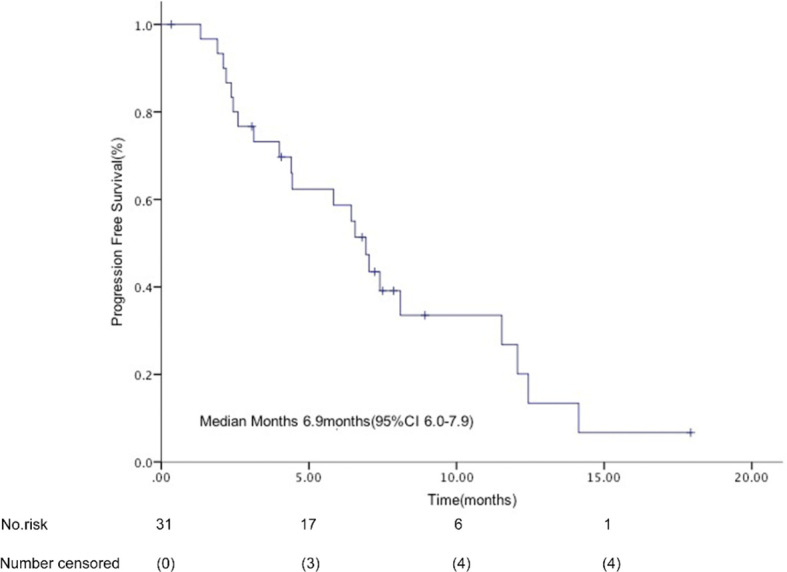
Kaplan-Meier graph for progression-free survival in all patients.